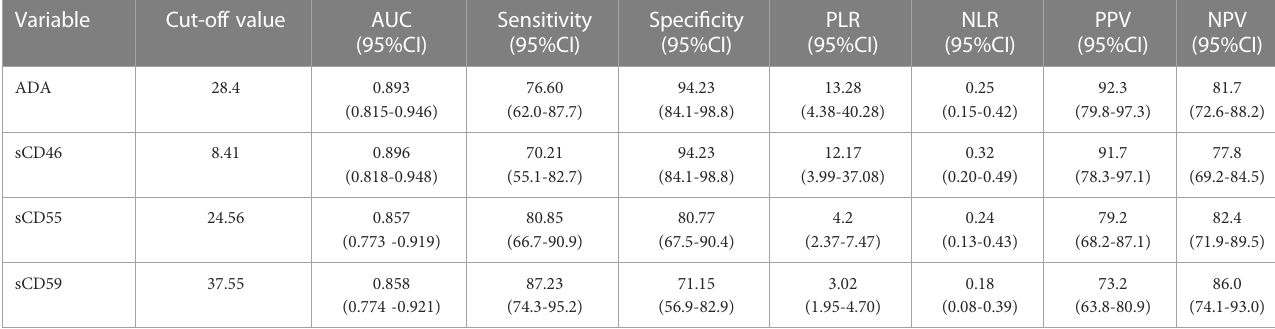
TABLE 3 Diagnostic performance of sCD46, sCD55 and sCD59 in PF in differentiating between patients with TPE and those with non-TPE. Variable